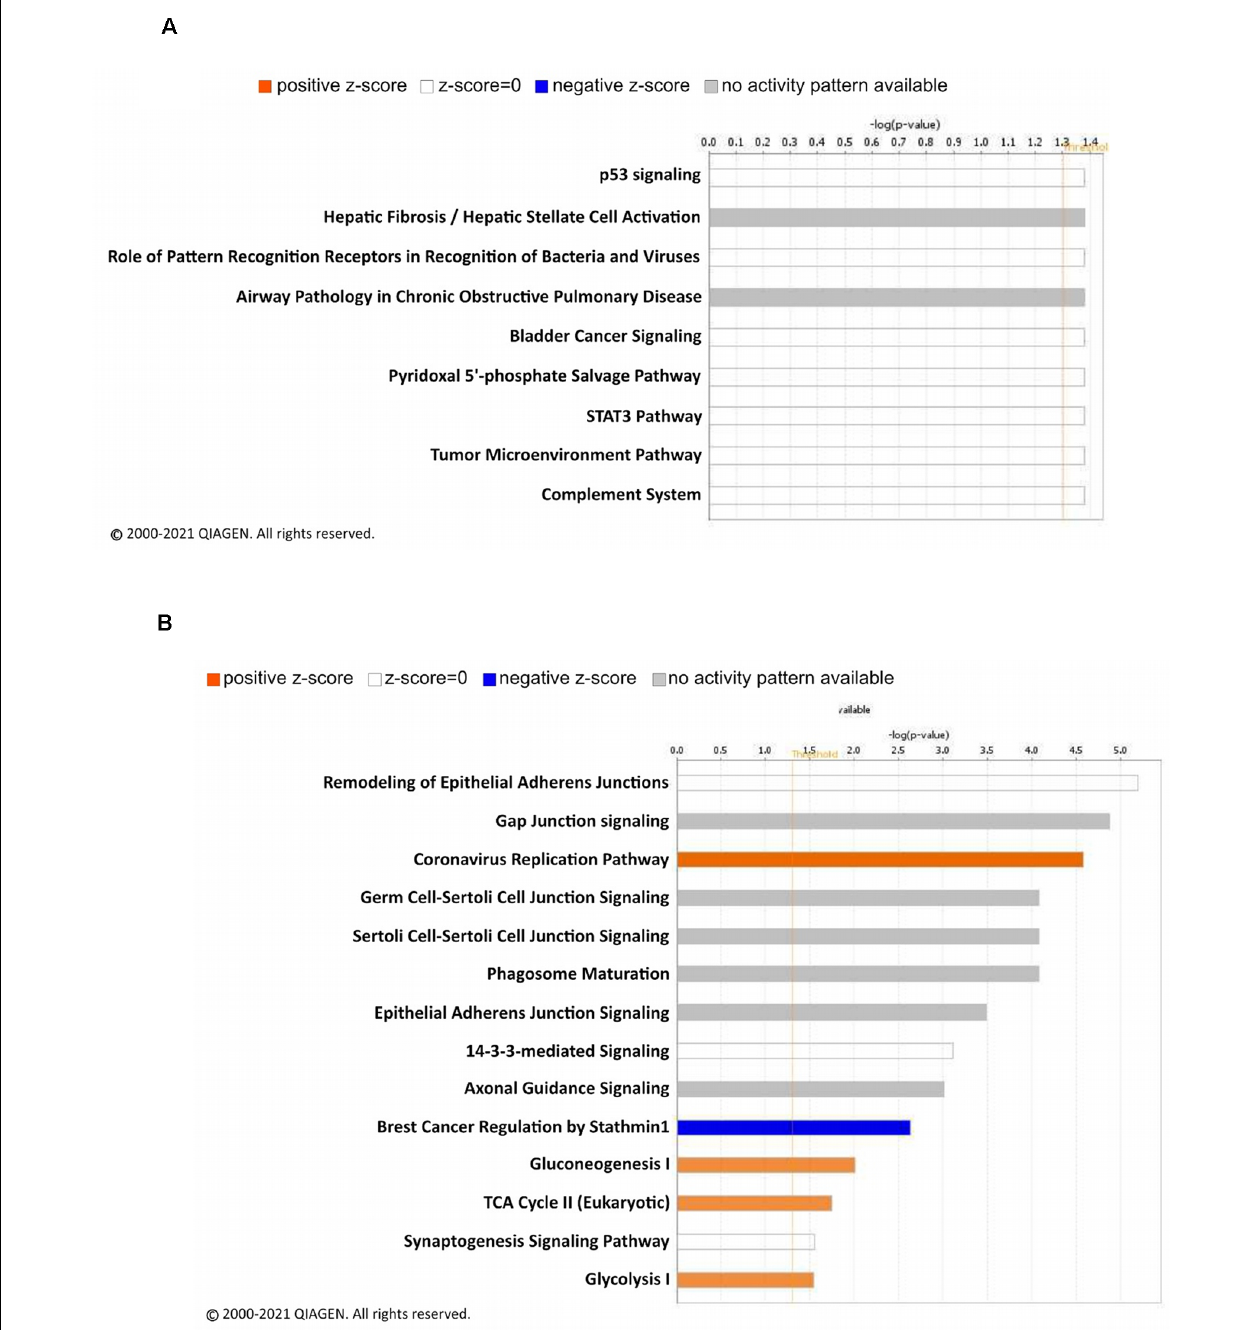
FIGURE 3 | Canonical signaling pathway analysis of linear polyubiquitin protein targets in the amygdala of male and female rats following fear conditioning. Ingenuity pathway analysis (IPA) was performed on samples that underwent mass spectrometry analysis, as described in Figure 2 . The top canonical pathways relevant to the regulated linear polyubiquitinated proteins in females (A) and males (B) are shown with their corresponding score (-log[p value]). A positive z-score indicates the predicted upregulation of specific cellular and molecular processes.